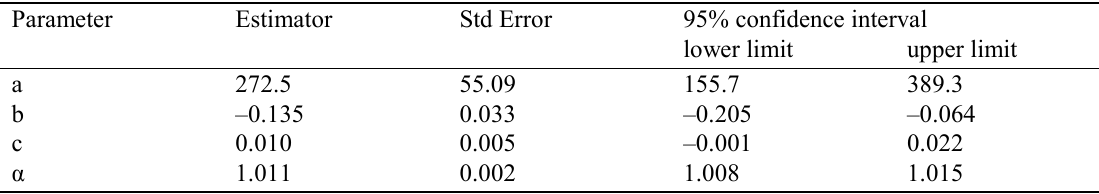
Fig. 1 Cultivated land area of Heibe province over the years. Table 3 Parameters of the equation.